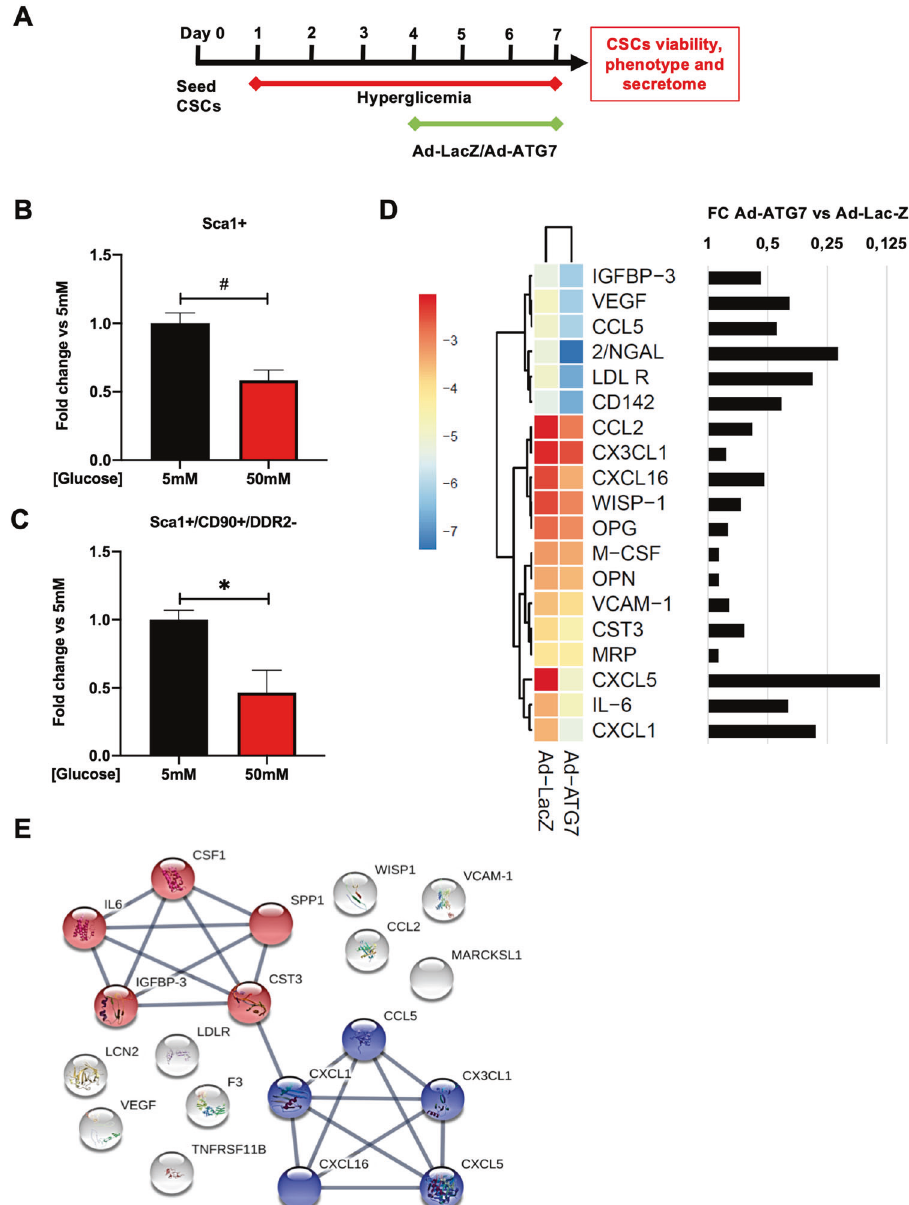
Fig. 6 Hyperglycemia deprives CSCs of primitive cells and alters their paracrine pro fi le. A Experimental timeline and design for autophagy modulation during hyperglycemia treatment. Quanti fi cation by fl ow cytometry of total Sca1 + (B) and Sca1 + /CD90 + /DDR2- (C) cells in the CSC population after 1 week of culture in 50 mM glucose, or 5 mM as control (n = 3). D Heatmap with hierarchical clustering of Euclidean distance, calculated on Log2 values from normalized optical density of protein arrays on conditioned media from ad-ATG7 or ad-LacZ transduced CSCs exposed to 50 mM glucose; the heatmap is shown associated to the fold change (FC) histogram of ad-ATG7 versus ad-LacZ levels, for a selection of the most modulated cytokines. E Network of functional associations from the STRING database among cytokines of interest, showing only associations with edge con fi dence >0.7 (high/highest). *P<0.05, (LDLR) in CSCs with ATG7 overexpression in response to hyperglycemia treatment. Functional association network analysis on the STRING database demonstrated a signi fi cant enrichment (False Discovery Rate >0.05) in several GO terms related to biological processes, molecular functions, and cellular compo- nents in ATG7-overexpressing CSCs versus control cells in response to hyperglycemia (Supplementary Table 1). Speci fi cally, two functional sub-networks emerged, as shown in Fig. 6E: one among chemokines (except CCL2), all belonging to the “ Chemo- kine receptors bind chemokines ” pathway (Supplementary fi g. 7A); another one connecting IL-6, IGFBP3, CSF1, cystatin C (CST3),